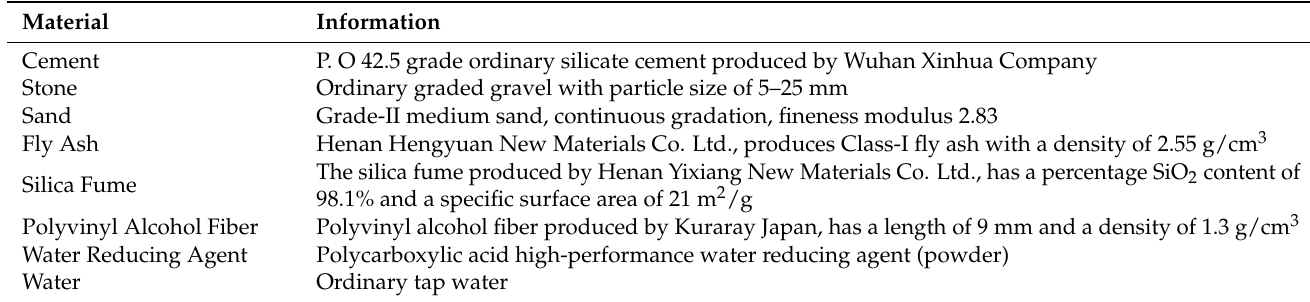
Table 1. Materials for test.